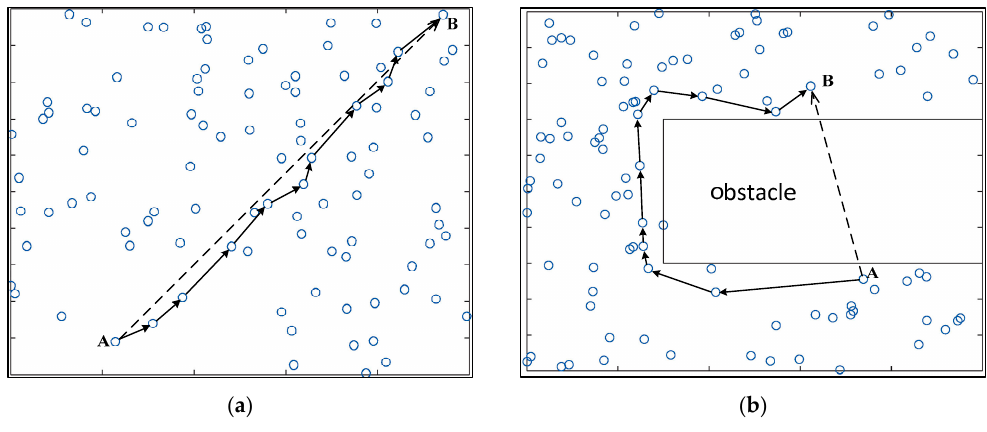
Figure 1. Different distribution of nodes ( a ) Isotropic network; ( b ) Anisotropic network.